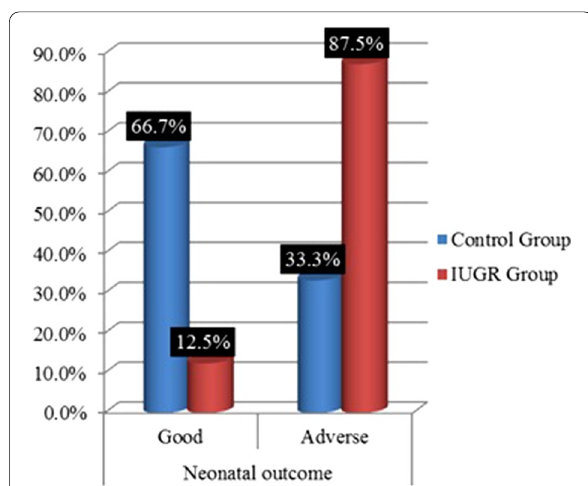
Fig. 4 Perinatal outcome in IUGR group with normal and